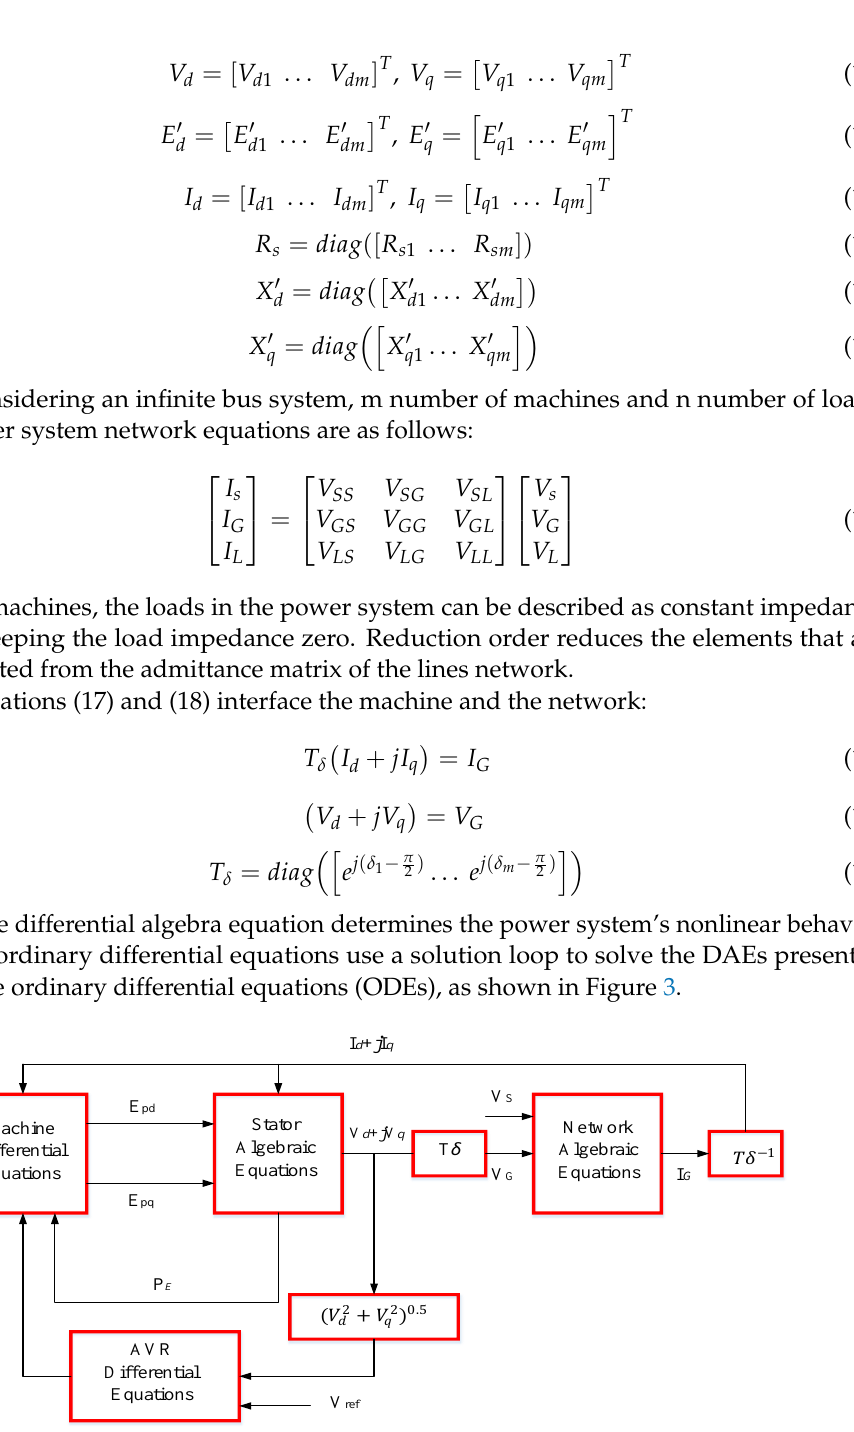
Figure 3. Diagrammatic representation of algebraic equations using ordinary differential equations [47].